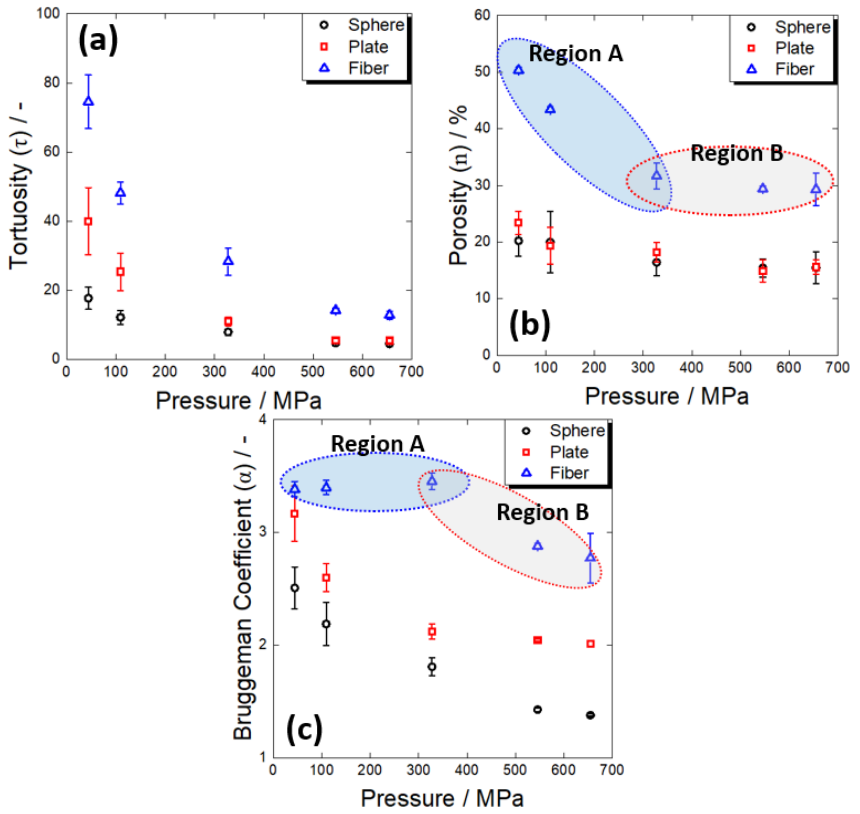
Figure 9. Variations in ( a ) tortuosity, ( b ) porosity, and ( c ) Bruggeman coefficient of the composite electrodes containing different shapes of Al 2 O 3 powders with pressing pressure. The regions A and B in the figures represent variations for fibrous Al 2 O 3 contacting electrode at low- and high-pressure regions,